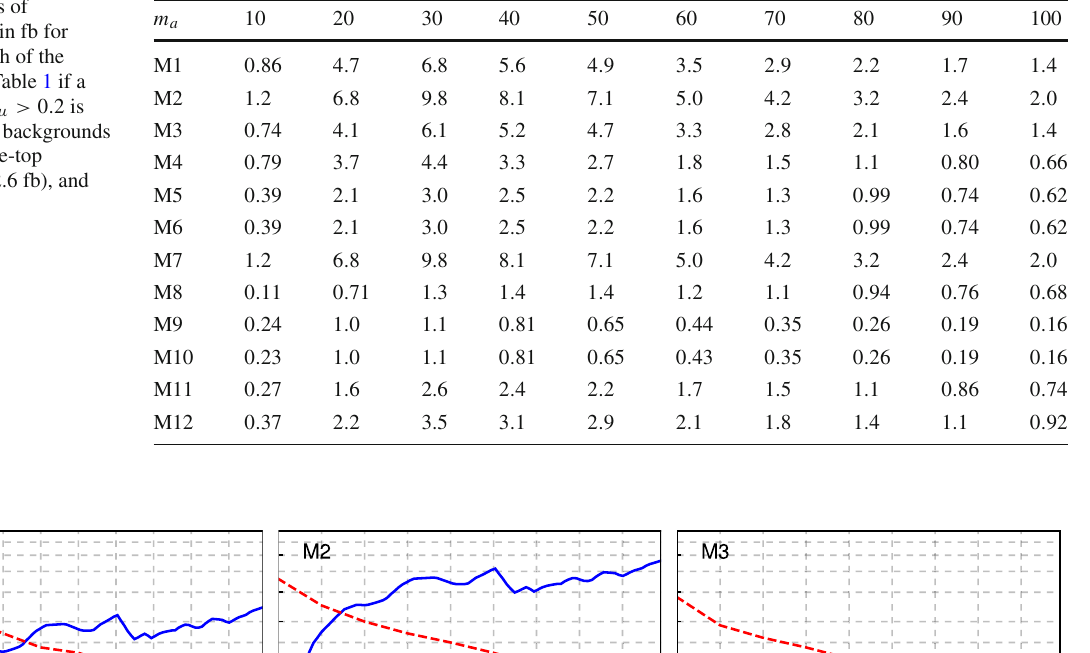
× BR ττ × (cid:15) in fb for prod . f a = 1 TeV for each of the models defined in Table 1 if a seperation cut Δ R e μ > 0 . 2 is imposed. The main backgrounds are di-top and single-top